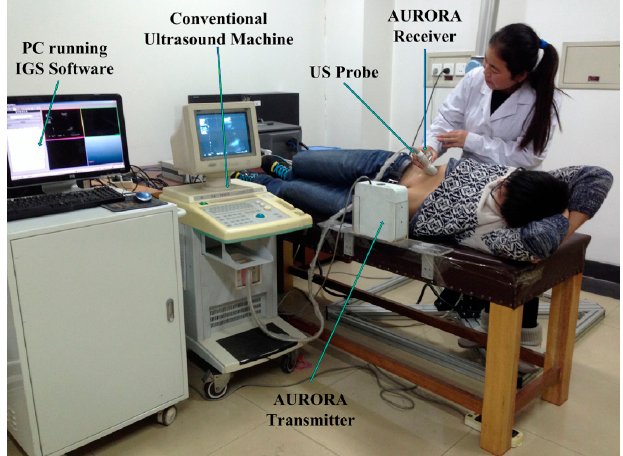
Figure 1. Freehand 3D US system. This is also the setup for the experiments. The spatial localizer is an electromagnetic tracking device called AURORA from Northern Digital Inc. (Waterloo, ON, Canada). IGS (image ‐ guided surgery) software serves as the 3D surface reconstruction and visualization program.